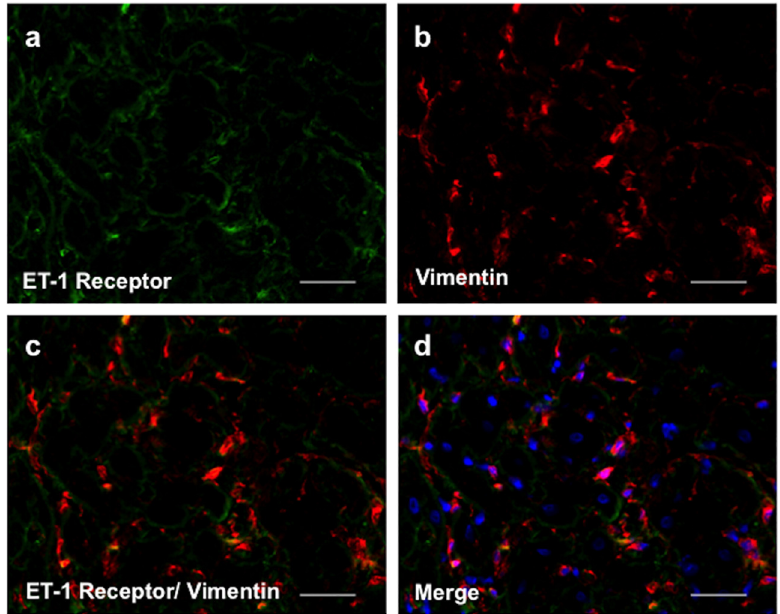
Fig 7. Immunofluoresence staining of ET-1 receptor expressed in cardiac fibroblasts (a-d). ( a ) represent ET-1 receptor (in green) and ( b ) Vimentin, a fibroblast marker (in red) from myocardial samples of the RV from a PAB heart. The orange colour in images c and d indicates overlapping of ET-1 receptor and Vimentin staining. ( d ) shows the merged image (a and b) including nucleis colored blue. Original magnification, ×400.